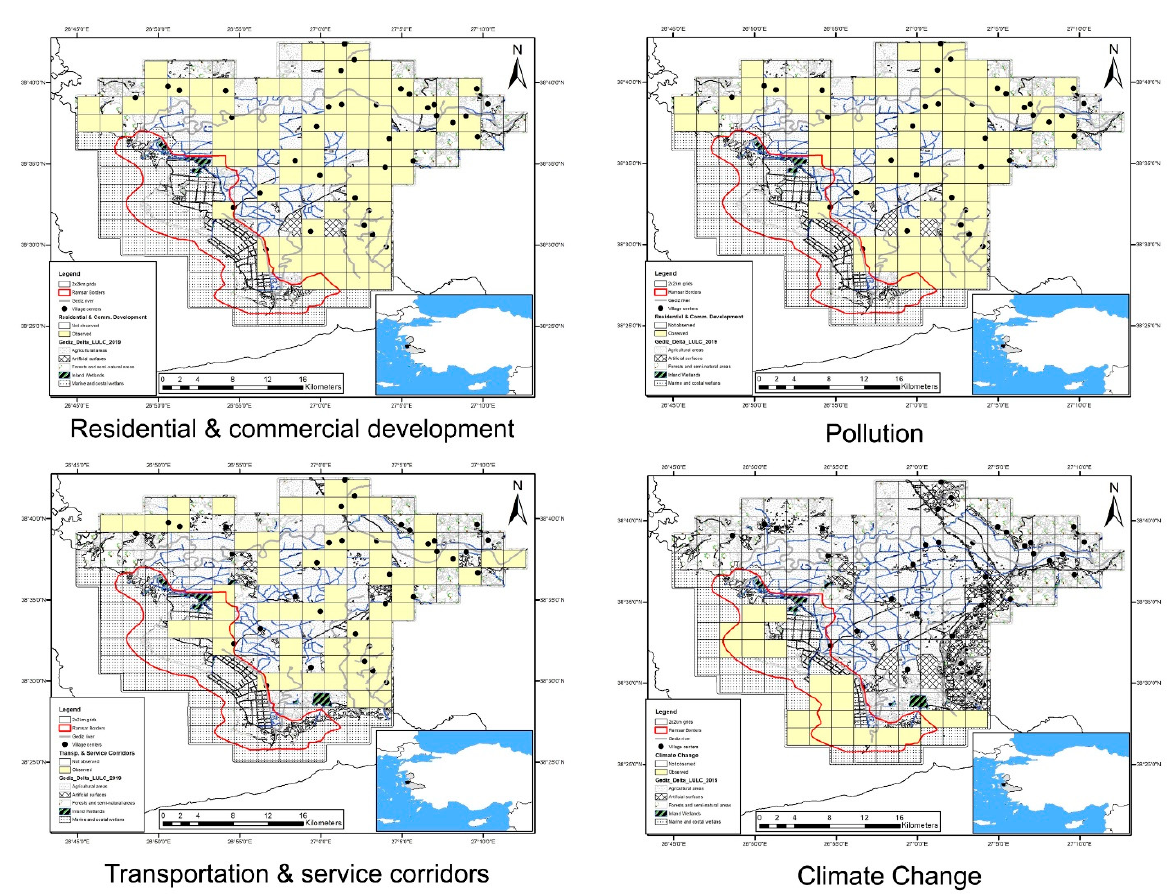
Figure A1. The maps show the grids where the four major the threats were identified through the field survey. Yellow colour represents where the threat was observed.